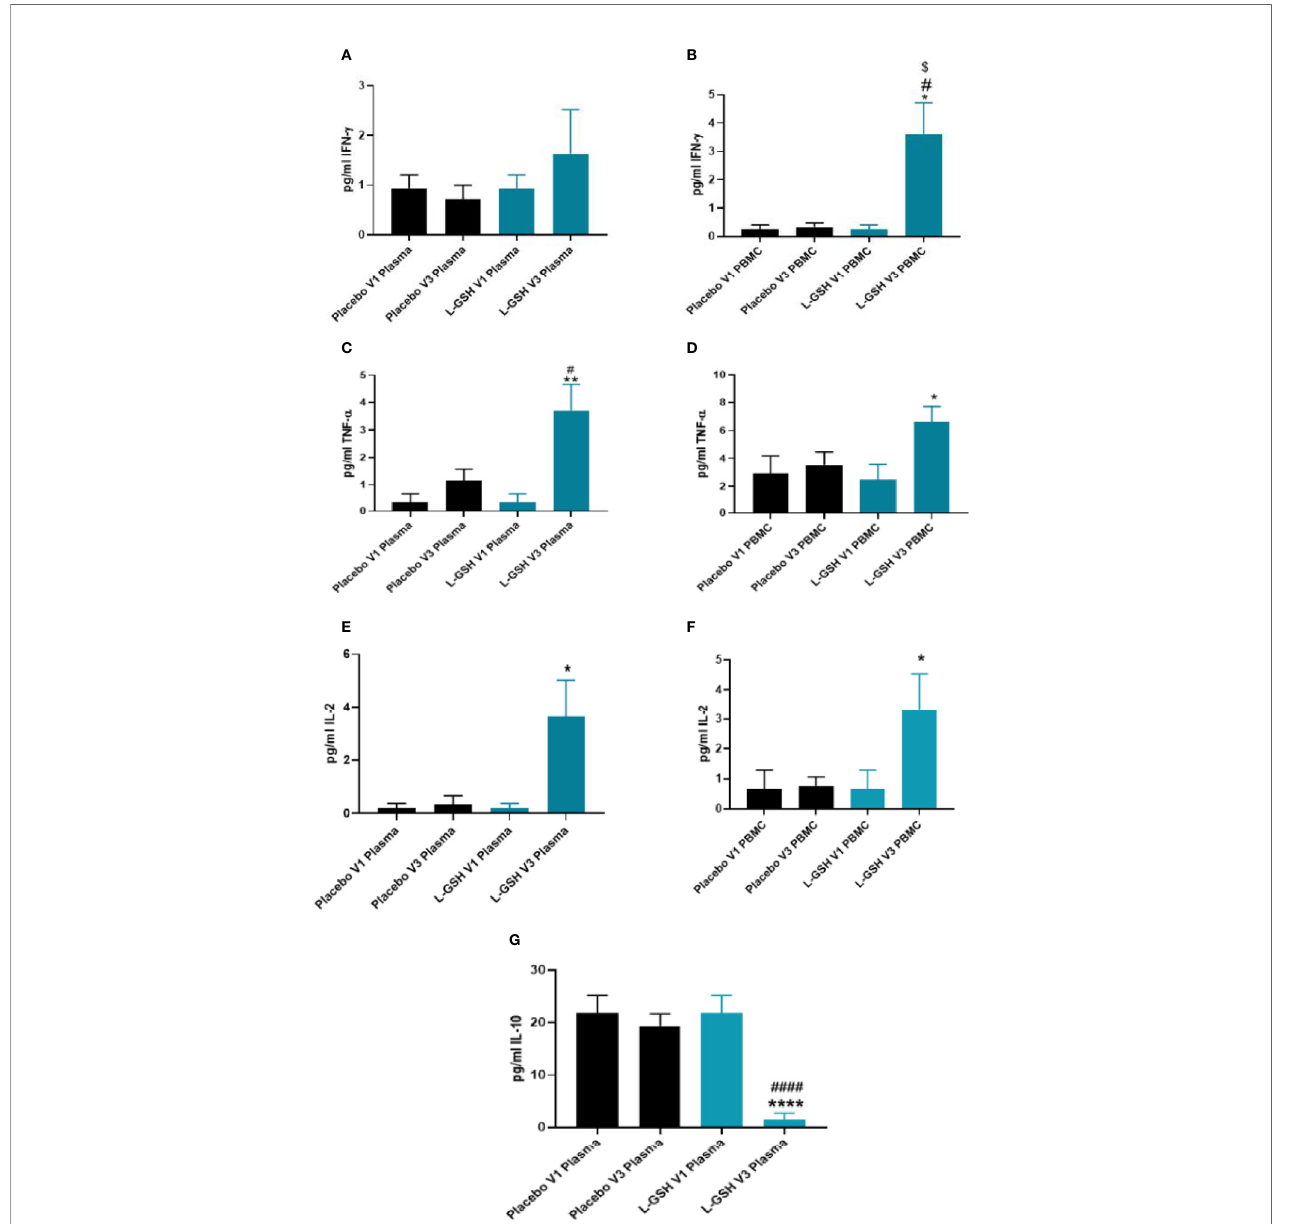
FIGURE 5 | Clinical trial fi ndings. Quanti fi cation of cytokines in plasma samples and PBMCs of individuals with T2DM on L-GSH/or placebo supplement. Levels of IFN- g in the plasma (A) and PBMCs (B) isolated from individuals with T2DM at pre- and post- L-GSH/or placebo supplementation were determined by spectrophotometry using an assay kit from Invitrogen. V1 represents plasma samples (A) or PBMCs (B) isolated from subjects with T2DM prior to L-GSH/or placebo supplementation. V3 represents plasma samples (A) or PBMCs (B) isolated from subjects with T2DM at three months post- L-GSH/or placebo supplementation. Levels of TNF- a in the plasma (C) and PBMCs (D) isolated from individuals with T2DM at pre- and post- L-GSH/or placebo supplementation were determined by spectrophotometry using an assay kit from Invitrogen. V1 represents plasma samples (C) or PBMCs (D) isolated from subjects with T2DM prior to L-GSH/or placebo supplementation. V3 represents plasma samples (C) or PBMCs (D) isolated from subjects with T2DM at three months post- L-GSH/or placebo supplementation. Levels of IL-2 in the plasma (E) and PBMCs (F) isolated from individuals with T2DM at pre- and post- L-GSH/or placebo supplementation were determined by spectrophotometry using an assay kit from Invitrogen. V1 represents plasma samples (E) or PBMCs (F) isolated from subjects with T2DM prior to L- GSH/or placebo supplementation. V3 represents plasma samples (E) or PBMCs (F isolated from subjects with T2DM at three months post- L-GSH/or placebo supplementation. Levels of IL-10 in the plasma (G) isolated from individuals with T2DM at pre- and post- L-GSH/or placebo supplementation were determined by spectrophotometry using an assay kit from Invitrogen. V1 represents plasma samples isolated from subjects with T2DM prior to L-GSH/or placebo supplementation. V3 represents plasma samples isolated from subjects with T2DM at three months post- L-GSH/or placebo supplementation. A p <0.05 is considered signi fi cant indicated by an asterisk (*). (**) indicates a p <.005, (****) indicates p <0.0001. A p <0.05 is considered signi fi cant indicated by an hashmark (#), (####) indicates p <0.0001. A p <0.05 is considered signi fi cant indicated by a dollar sign